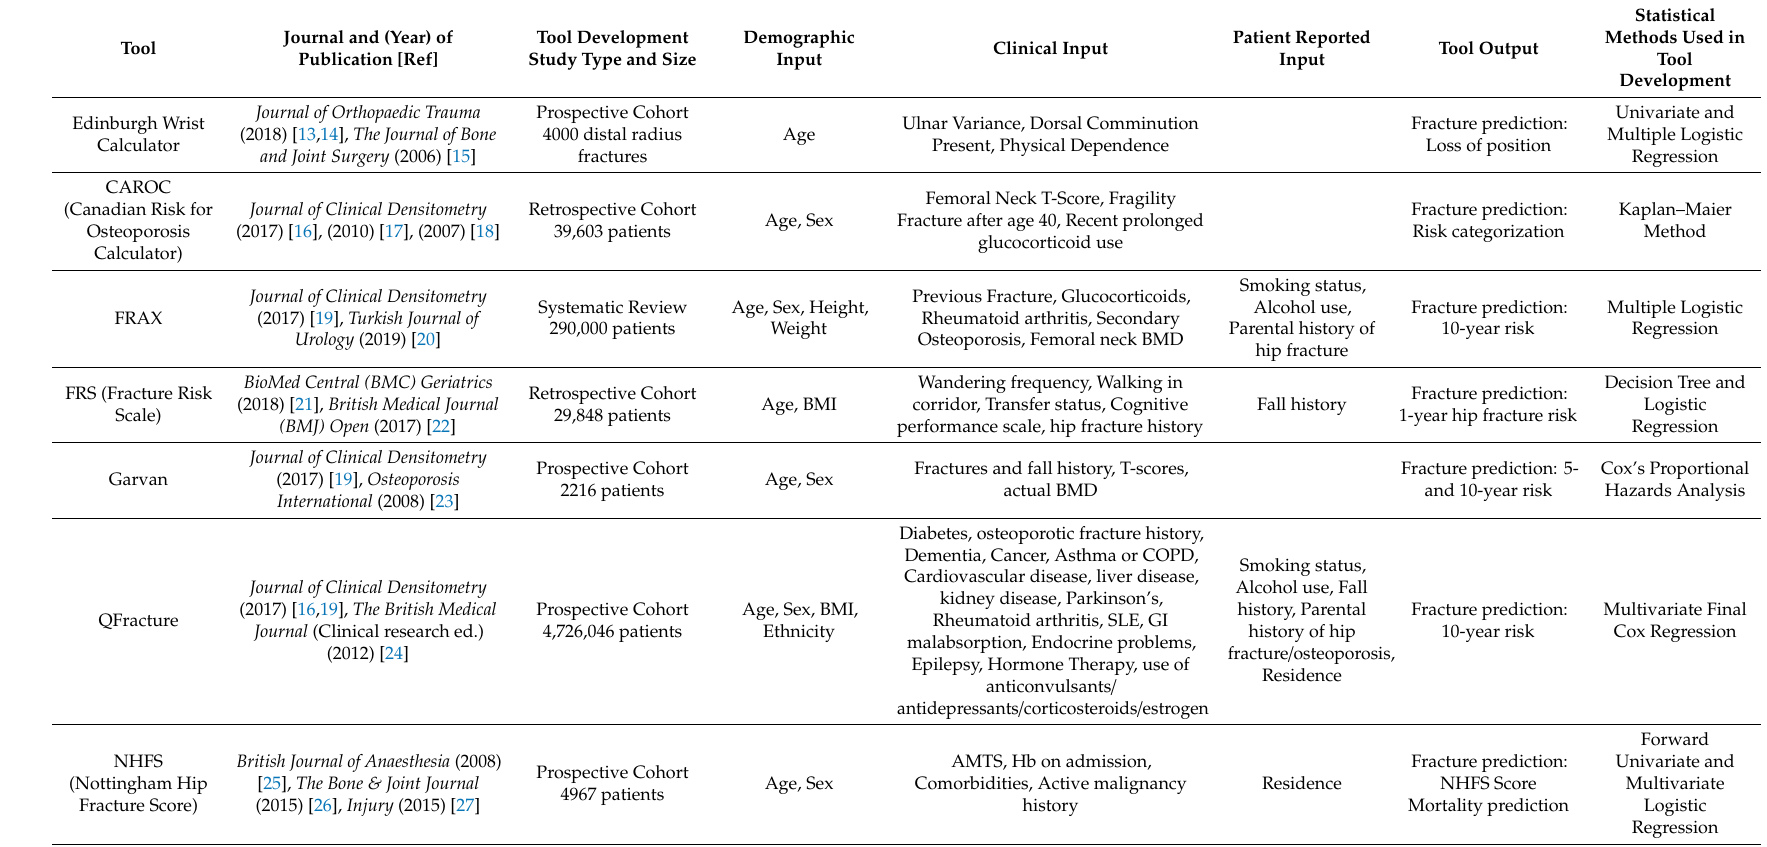
Table 4. Tools Categorized by